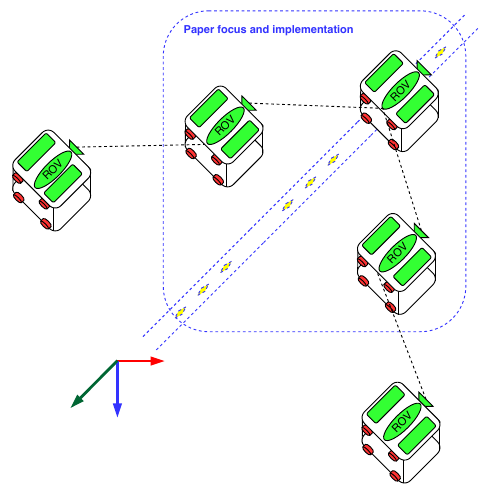
Figure 1. Proposal of the concept of a group of